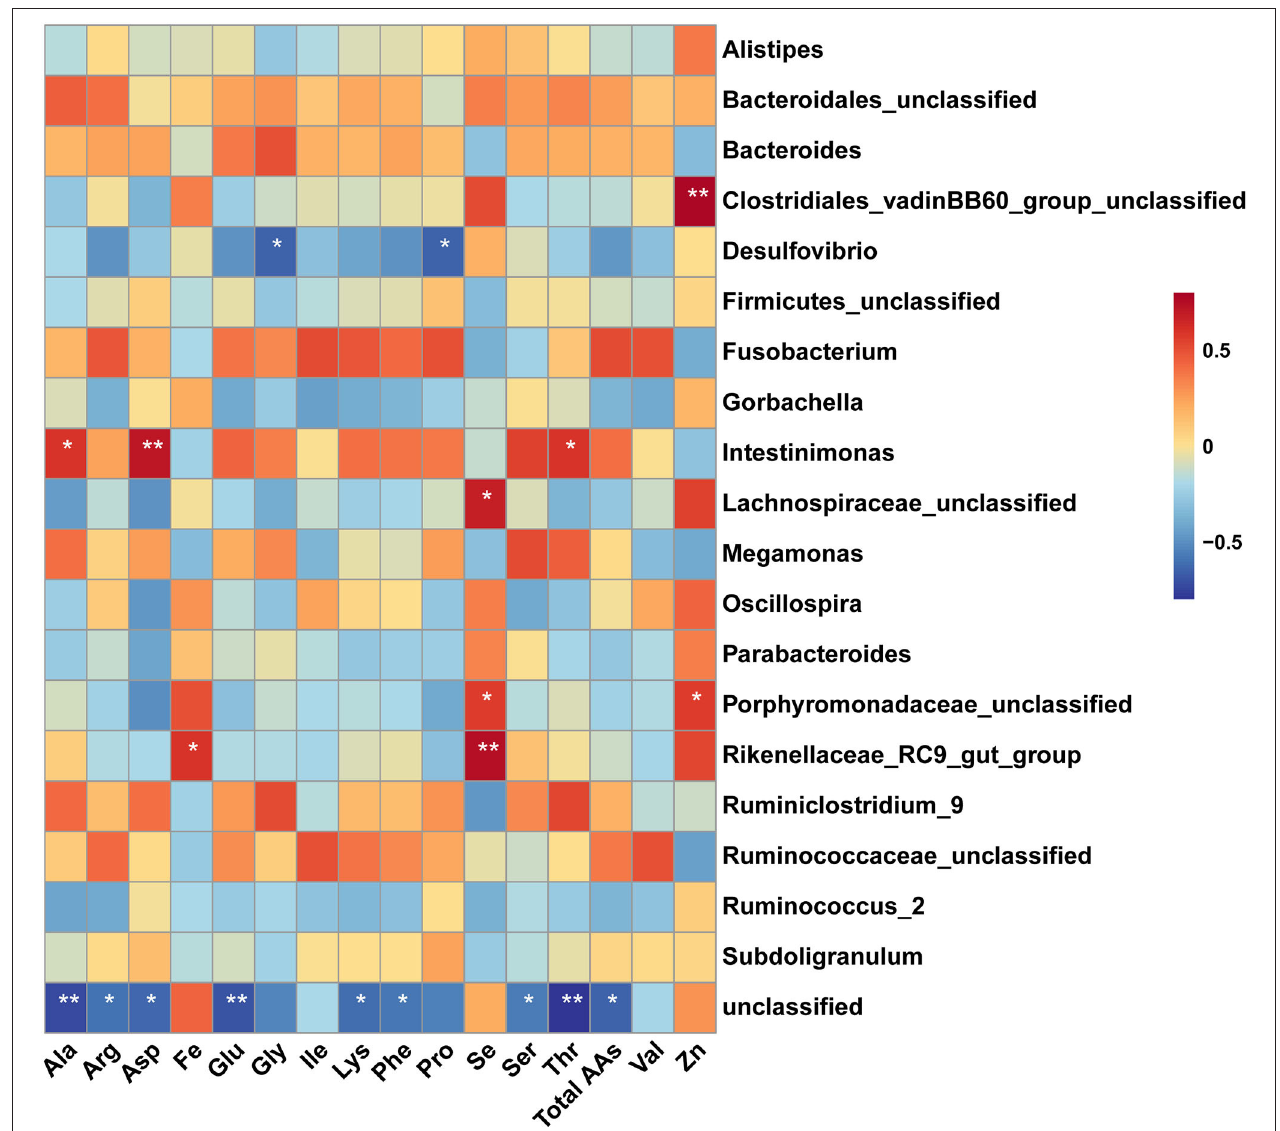
FIGURE 7 | Spearman’s correalation analysis of amino acid and dominant genus bacteria. The colors range from blue (negative correlation) to red (positive correlation). * Indicates significant difference ( P < 0.05), ** indicates extremely significant difference ( P <